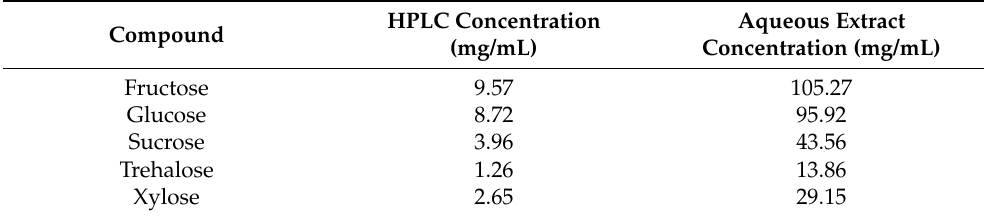
Table 2. Concentrations of hydrolytic sugars found in aqueous fractions obtained by the thermo- chemical liquefaction of Eucalyptus globulus , characterised by